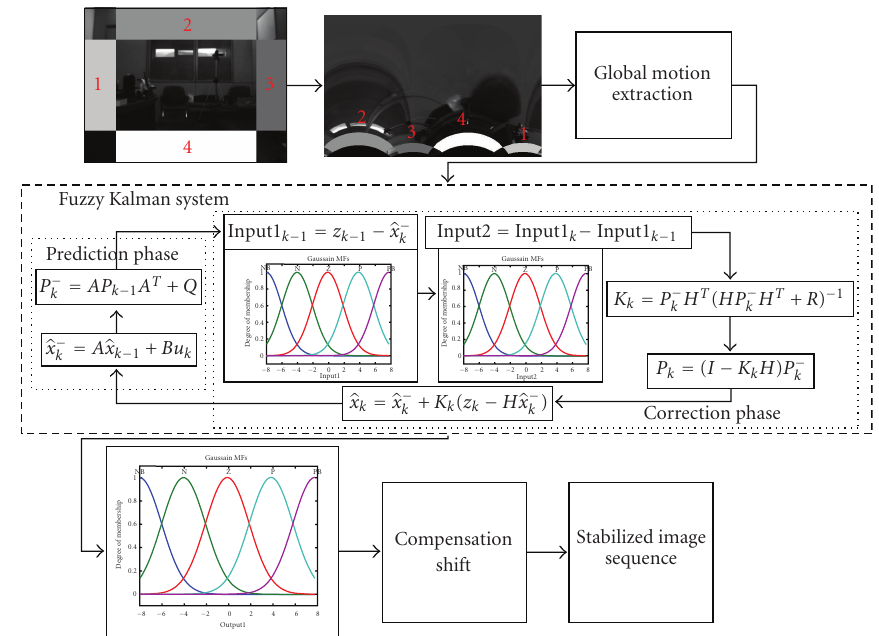
Figure 4: The block diagram of the fuzzy Kalman filter.